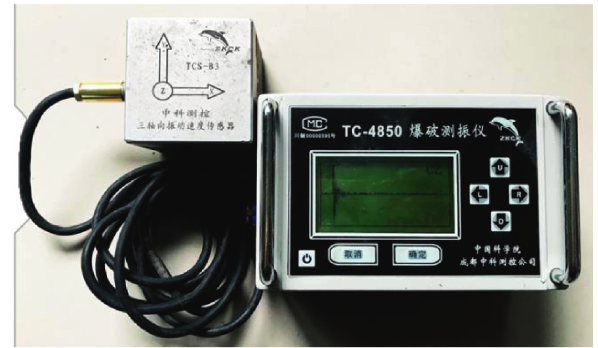
Figure 10: Blasting vibration test instrument.